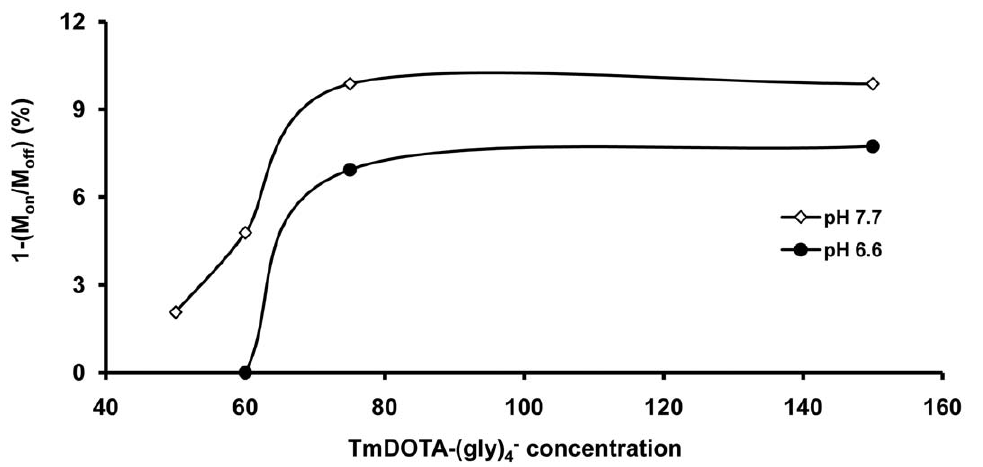
Figure 7. Amide proton CEST intensity from liposomal-encapsulated TmDOTA-(gly) 4 2 . Each amide proton CEST intensity was measured at the frequency of the exchanging –NH protons (-51 ppm) in an aqueous suspension of liposomes filled with TmDOTA-(gly) 4 2 in the inner core (the indicated concentrations were for the stock solutions of TmDOTA-(gly) 4 2 used in preparing the liposomes) at 9.4 T and 310 K. (B 1 =7.0 m T; presaturation time=6 s).